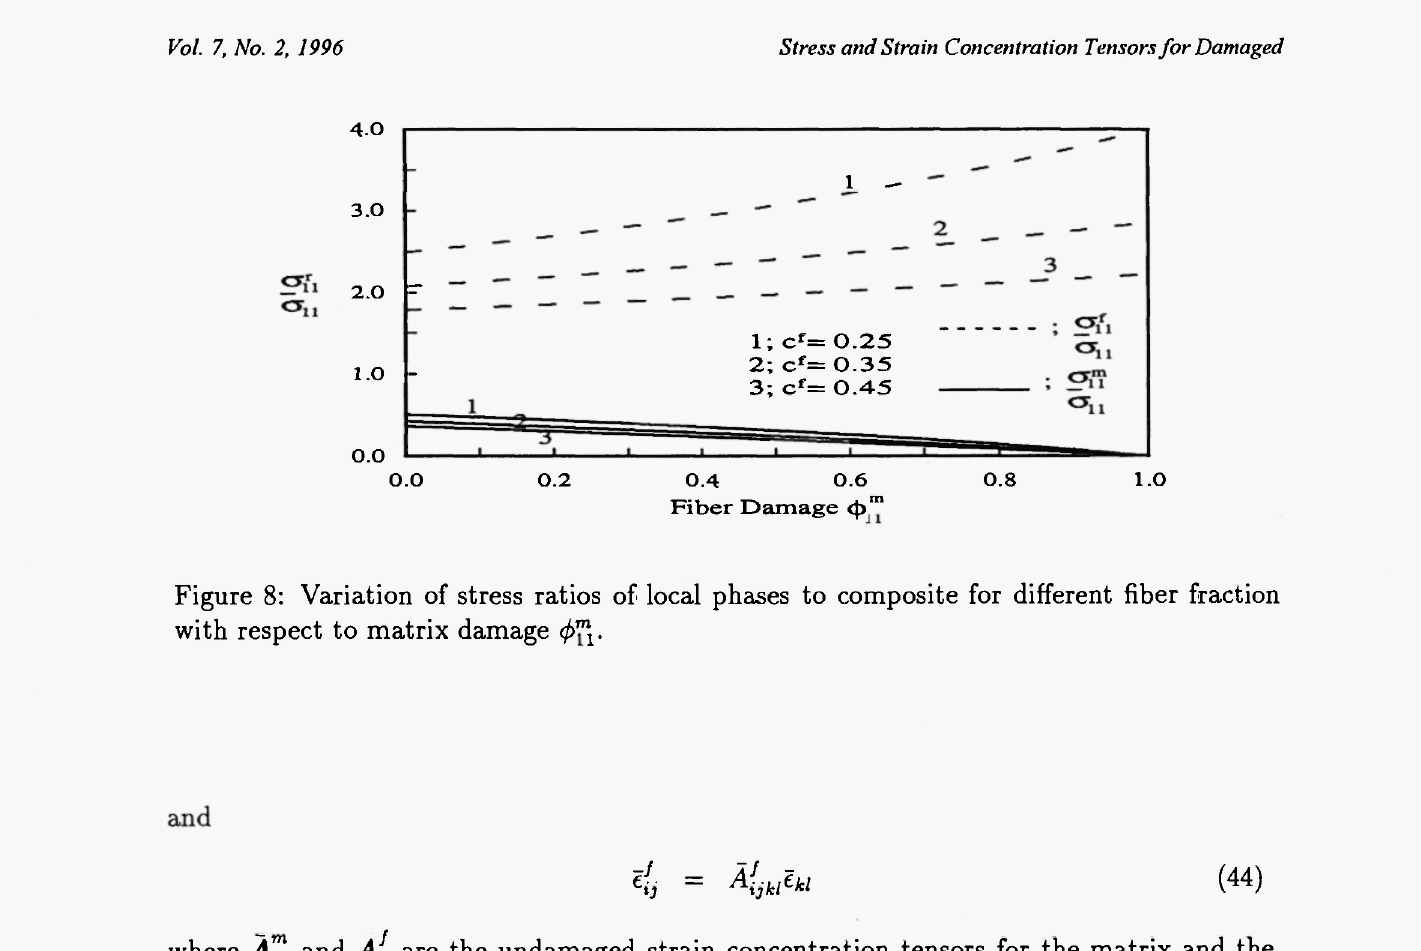
Figure 8: Variation of stress ratios of local phases to composite for different fiber fraction with respect to matrix damage φ™